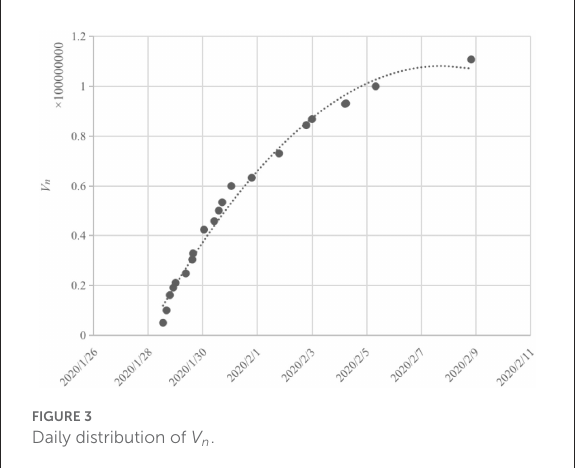
FIGURE3 Daily distribution of V n